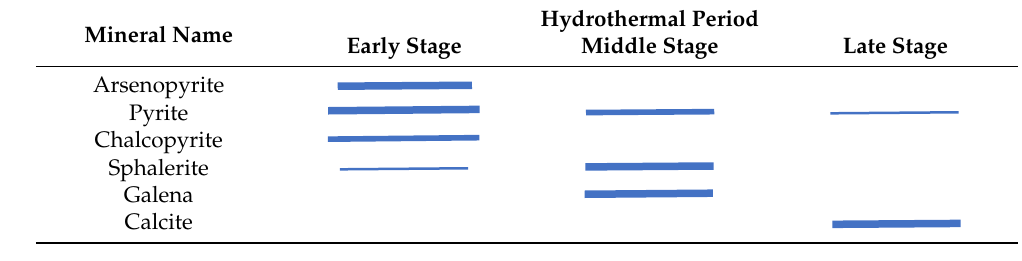
Table 2. Mineral formation sequence of the Jilinbaolige deposit.